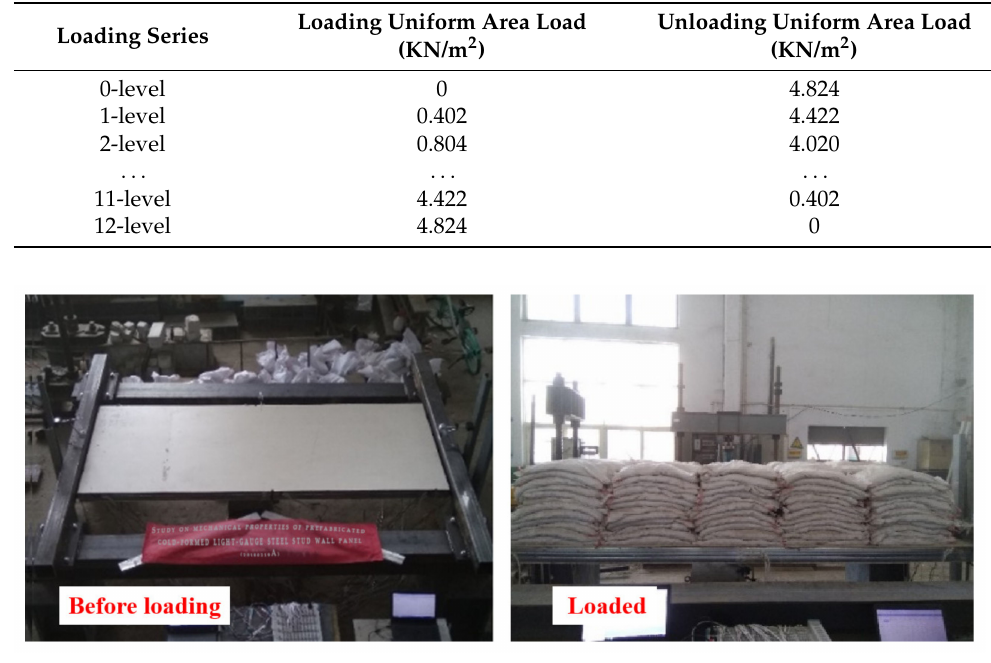
Figure 6. Full view of the load